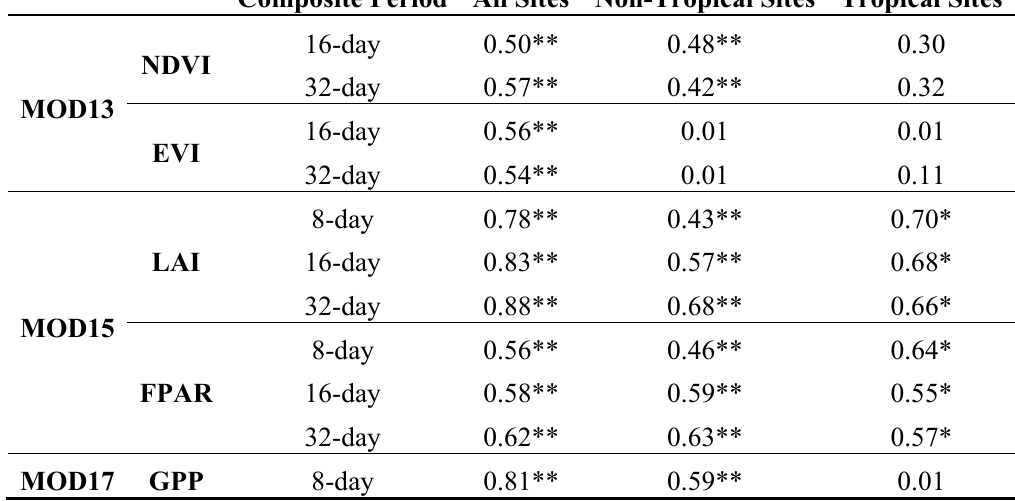
Table 4. Summary of R 2 between each MODIS product and flux tower annual GPP.